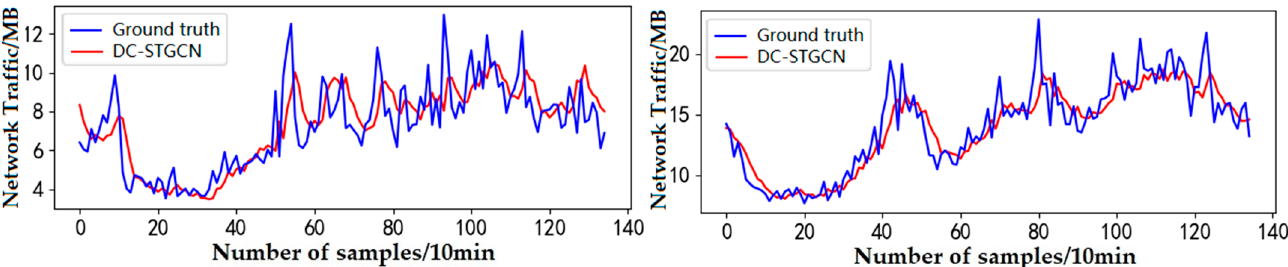
Figure 12. Visualization of one-step prediction results for the working day dataset.